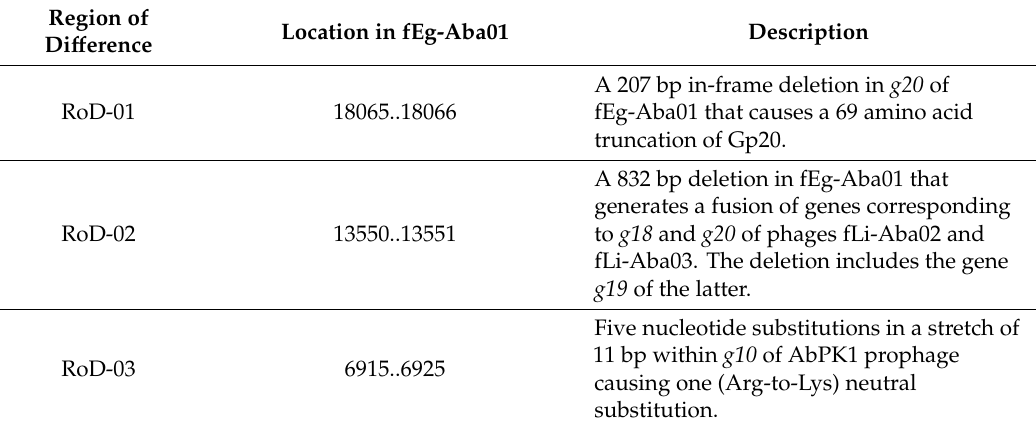
Table 3. The regions of di ff erences (RoD) between the nucleotide sequences of the three temperate Acinetobacter phages and the prophage loci of A. baumannii strains AbPK1, #5707 and #5920. See Figure S5 for